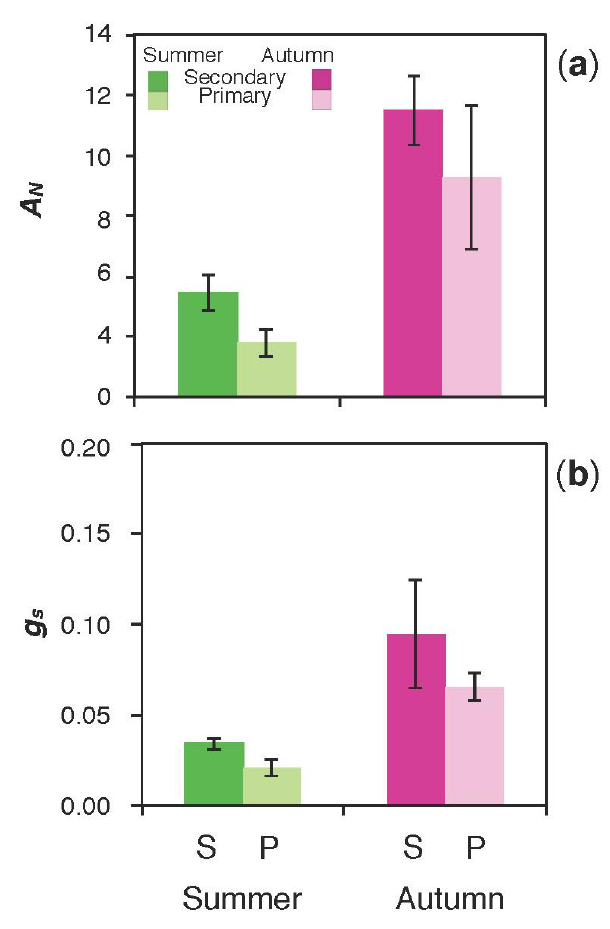
Figure 7. Gas exchange parameters measured in intact needles in the field and under natural conditions. ( a ) Net carbon assimilation ( A N ) in µ mol CO 2 m − 2 s − 1 . ( b ) Stomatal conductance ( g s ) in mol H 2 O m − 2 s − 1 . Data are mean ± SE ( n = 3–5). No significant differences were found between needle types.